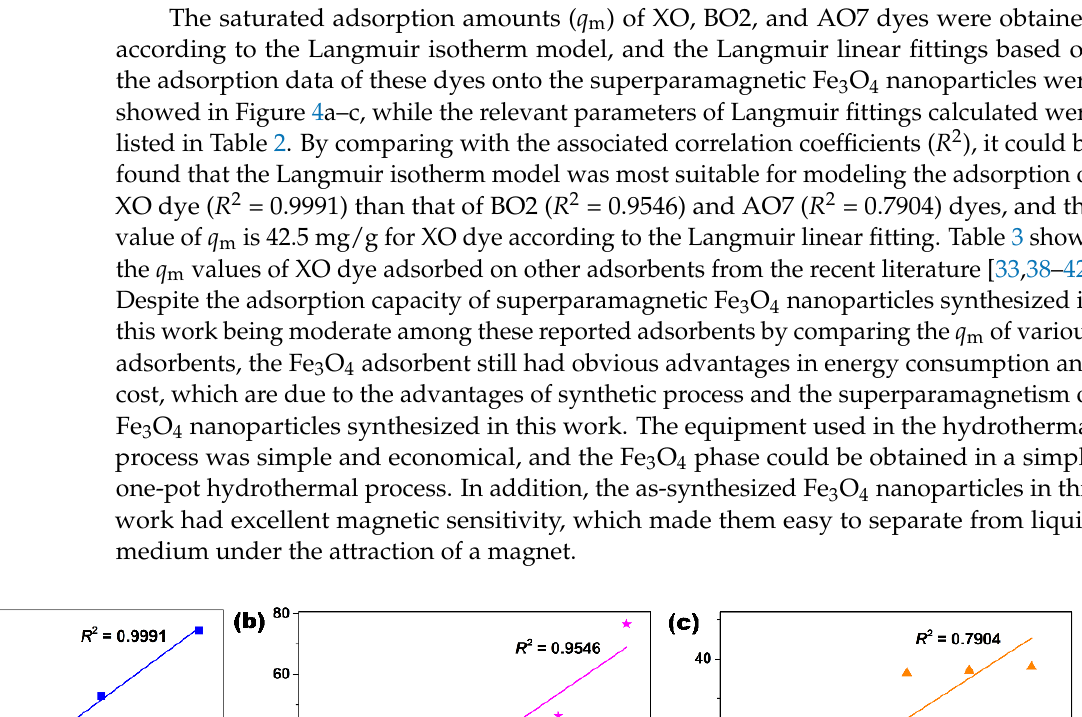
Figure 3. Time–dependence of adsorption profiles of (a) XO; (b) BO2; and (c) AO7 dyes with the presence of superparamagnetic Fe 3 O 4 powders. ([Fe 3 O 4 ] = 1.0 g/L; [dye] = 10 mg/L; Room tempera- ture; without pH preadjustment).